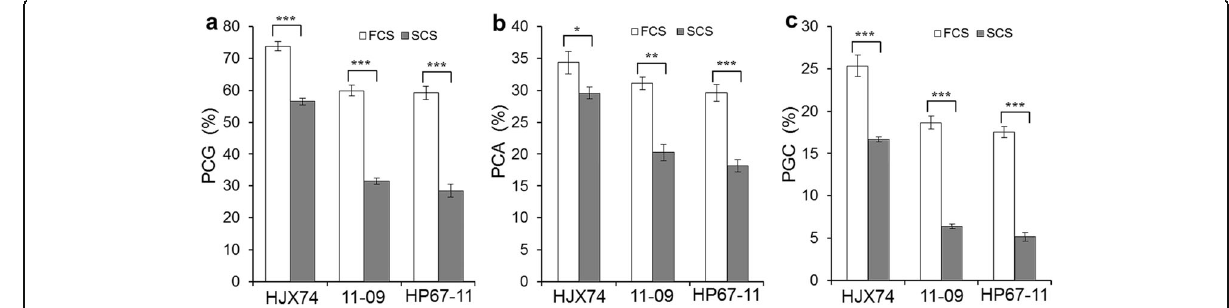
Fig. 5 The difference of chalky traits between first cropping seasons (FCS) and second cropping seasons (SCS) in HJX74, 11 – 09 and HP67 – 11. PCG percentage of chalky grain ( a ). PCA Percentage of chalky area ( b ). PGC Percentage of grain chalkiness ( c